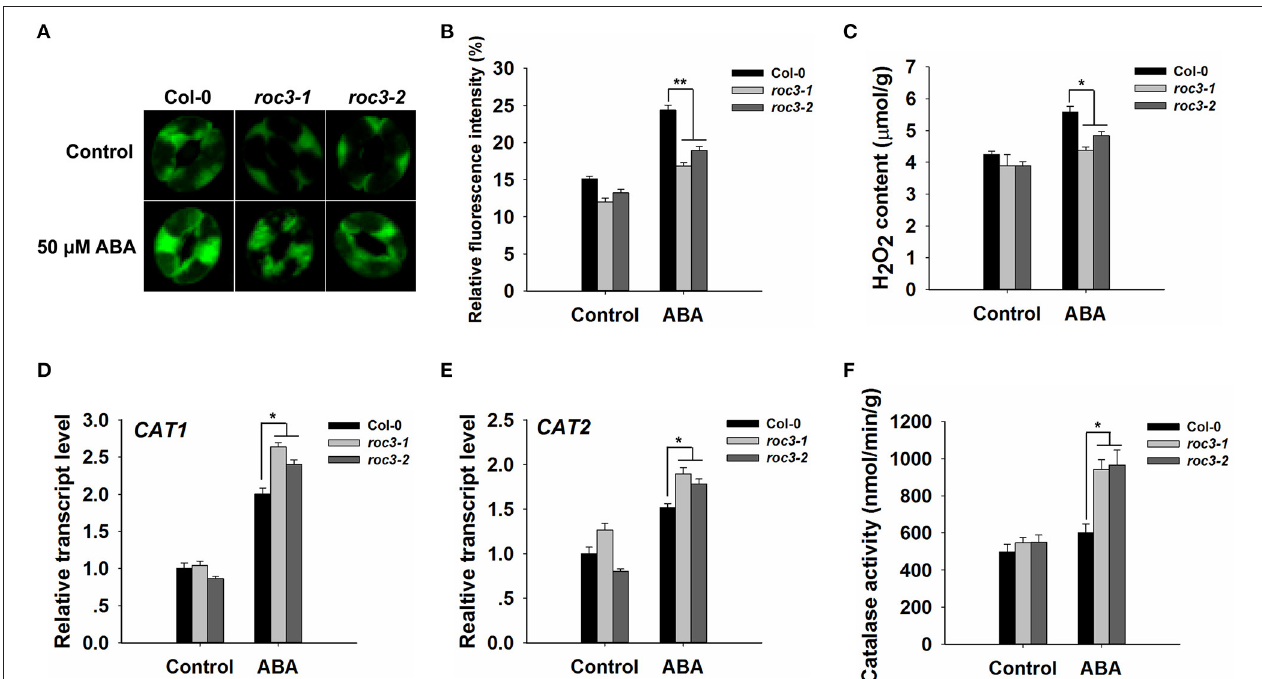
FIGURE 5 | The accumulation of ROS is less efficient in roc3 mutants than in WT guard cells. (A) Laser confocal micrographs revealing the ROS content of guard cells sampled from WT or roc3 mutant plants either exposed or not exposed to ABA; the fluorescent signal is generated from CM-H 2 DCFDA. (B) Quantification of the fluorescence intensities shown in (A) . At least 100 guard cells were sampled from each genotype. Error bars represent the SE ( n = 100). The experiments were repeated three times with similar results. (C) The H 2 O 2 content in the leaf of WT and roc3 plants, either exposed or not exposed to 50 µ M ABA. Values shown in the form mean ± SE ( n = 3). (D,E) Relative transcript abundances assessed using qRT-PCR in plants either exposed or not exposed to ABA: (D) CAT1 , (E) CAT2 . Data are shown as means ± SE ( n = 3). (F) Quantification of catalase activity assay in WT and roc3 mutants, either exposed or not exposed to 50 µ M ABA. Values shown in the form mean ± SE ( n = 3). *,**: values differed significantly from WT ( P < 0.05, 0.01).